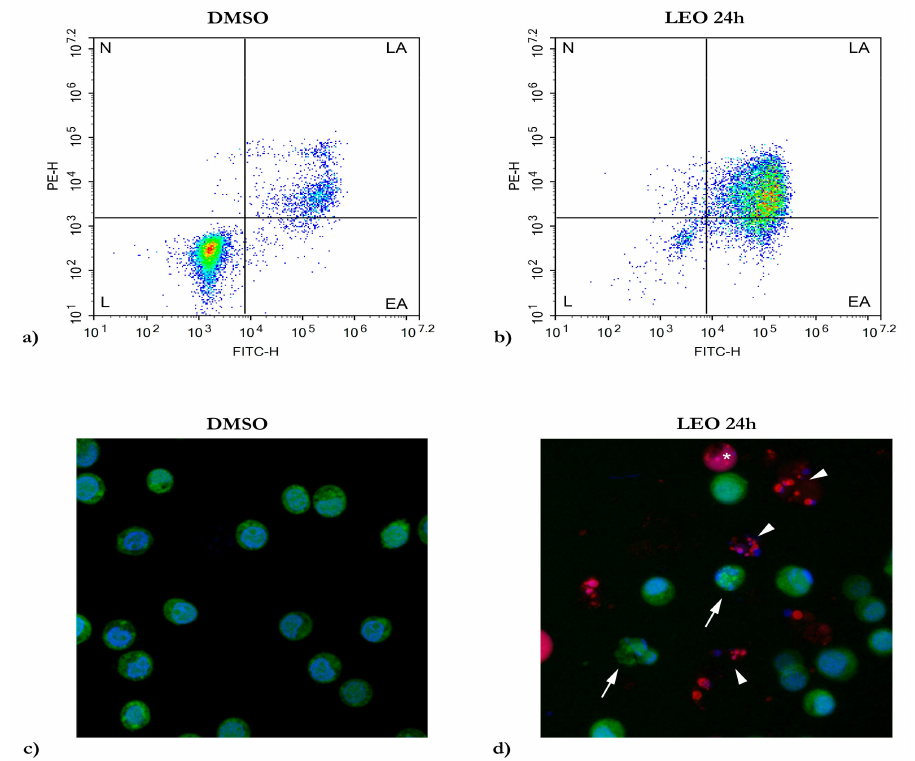
Figure 1. Evaluation of apoptosis induced by LEO treatments. Flow cytometry analysis for Annexin V-FITC / PI staining. ( a ) DMSO treated HL60 cells, solvent control; ( b ) HL60 treated with LEO for 24 h; (L) live cells, (EA) early apoptotic cells, (LA) late apoptotic cells, (N) necrotic cells. ( c , d ) Apoptosis assay using fluorescein diacetate (FDA), propidium iodide (PI), and Hoechst 33342, in a confocal microscopy analysis in samples treated with DMSO for 24 h ( c ) and with LEO for 24 h ( d ). EA (arrows), LA (arrows heads), N